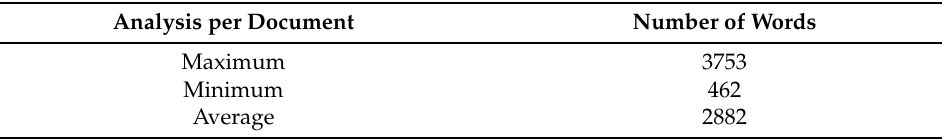
Table 3. The statistical analysis of the data after